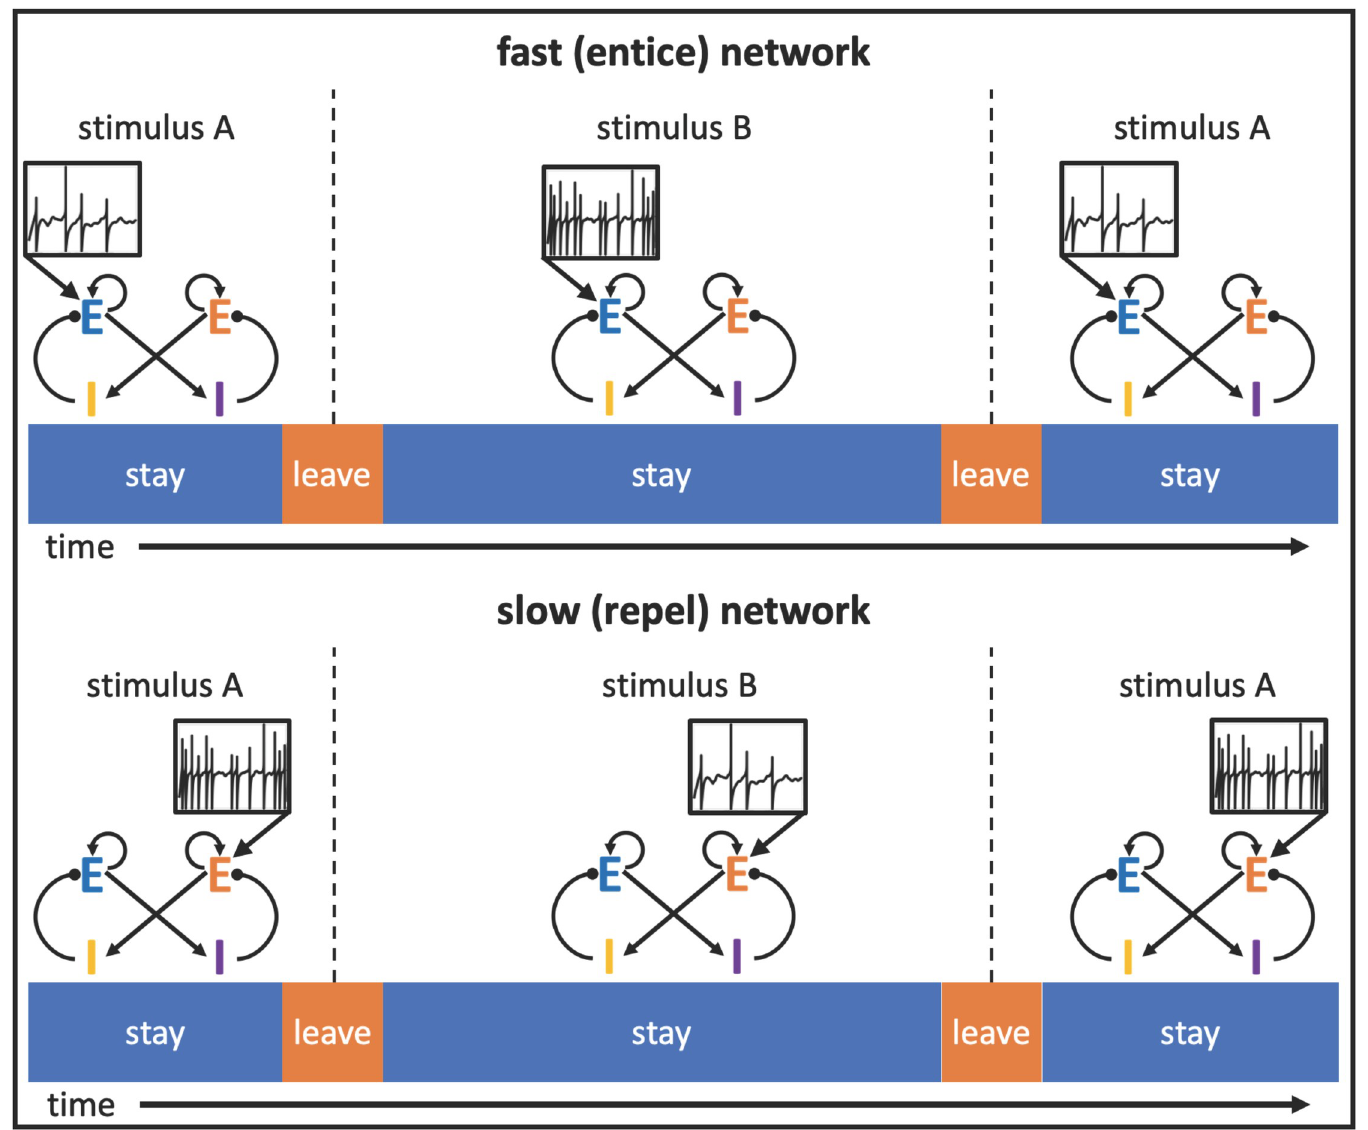
Fig 4. Example of a taste preference task simulation. Animals alternate between a less palatable stimulus A and a more palatable stimulus B. In the intrinsically fast- switching “entice-to-stay” network, the increased palatability arises from greater excitatory input to the excitatory “stay” pool of neurons, whereas in the intrinsically slow- switching “repel-to-leave” network, the increase in palatability is produced by a reduction of excitatory input to the excitatory “switch” pool of neurons.